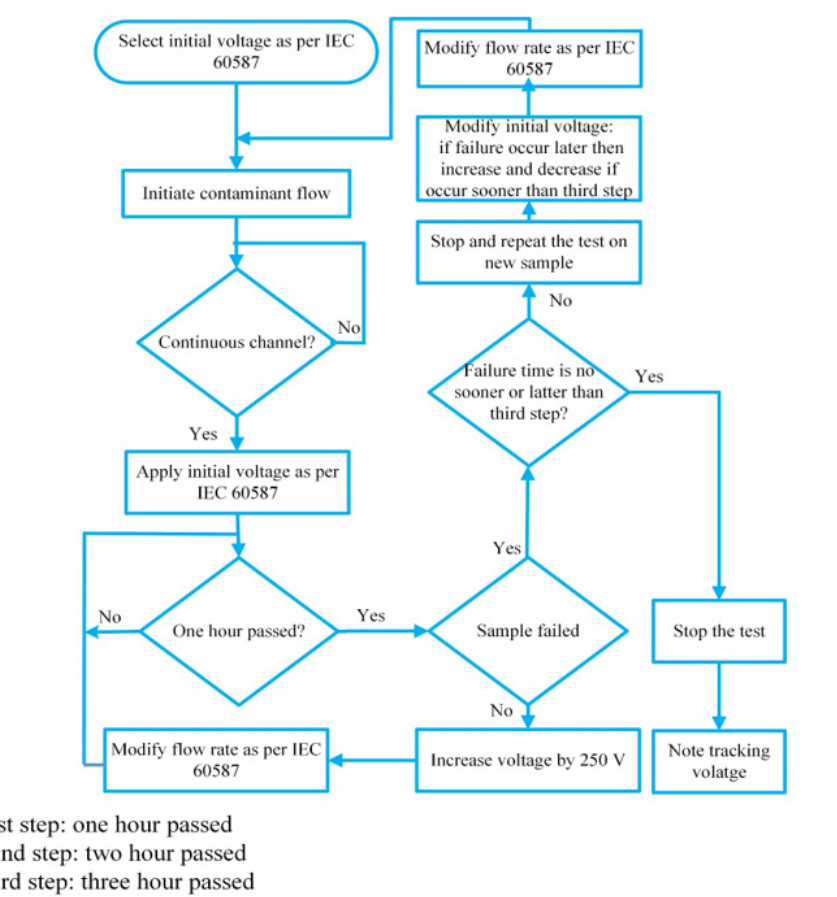
Figure 2. Flow chart of inclined plane testing (IPT).